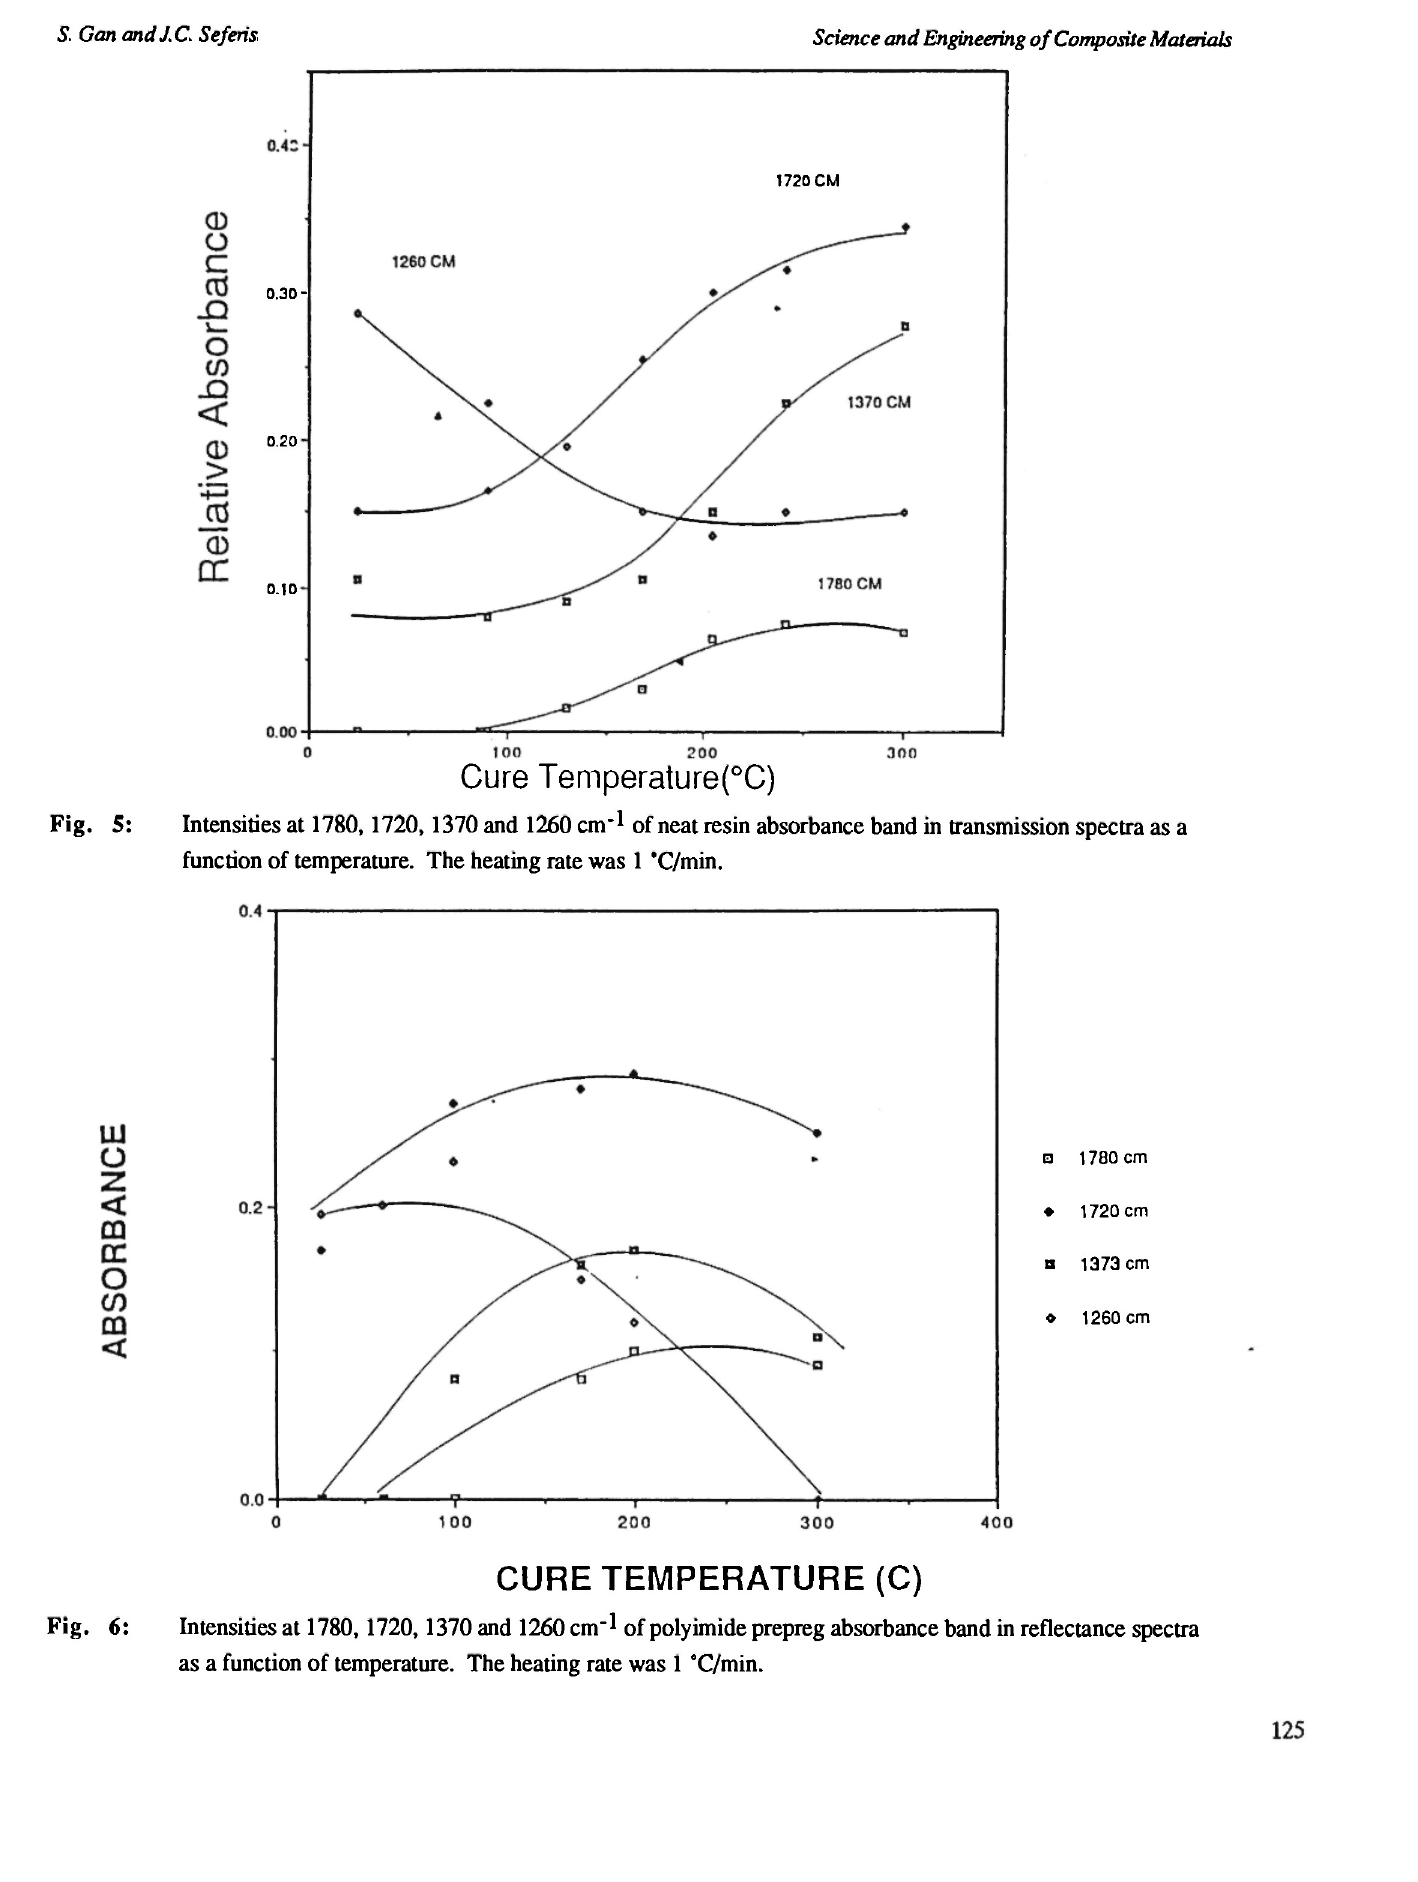
CURE TEMPERATURE (C) Fig. 6: Intensities at 1780,1720,1370 and 1260 cm" 1 of polyimide prepreg absorbance band in reflectance spectra as a function of temperature. The heating rate was 1